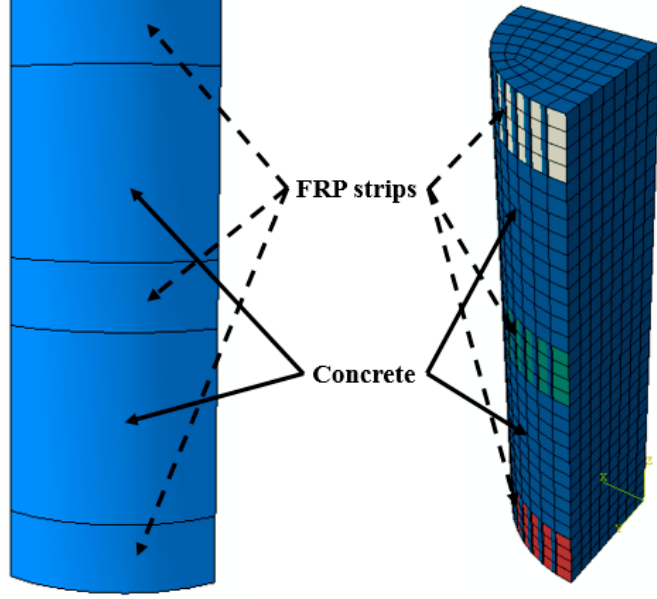
Figure 13. Symmetry FE model for a partially FRP-confined circular column.